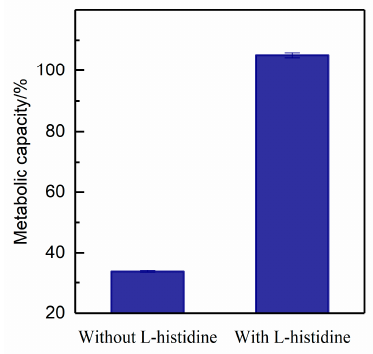
Figure 6. The percentage of A. acidoterrestris with metabolic capacity after being treated by cold plasma (input power: 1.32 kV; gas flow: 130 mL/min) for 60 s with and without L-histidine, as measured by a resazurin-based assay kit; Ex/Em: 560/590 nm. The investigation set the plasma-untreated sample as 100%.